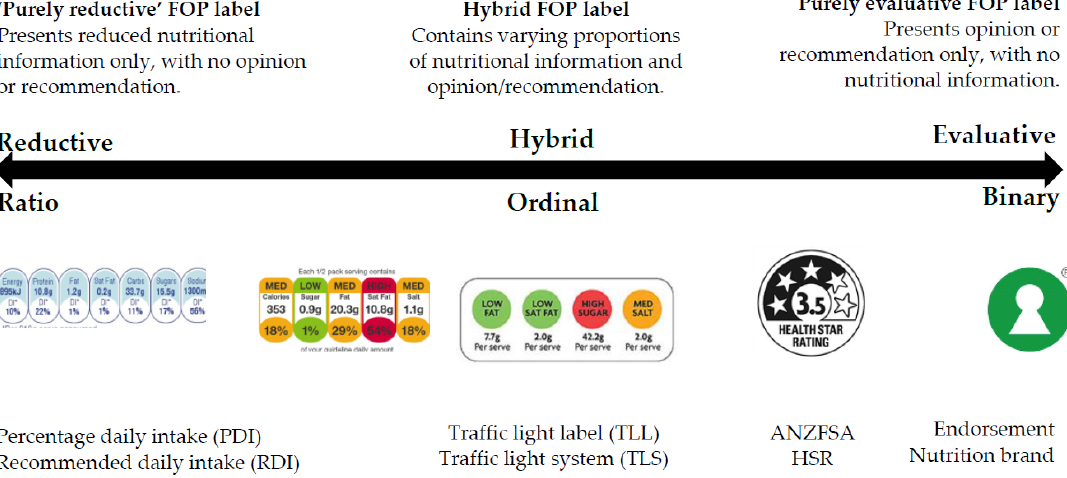
Figure 1. Evaluative/reductive based typology of front of pack (FOP) labels ([6], Reprinted with permission).